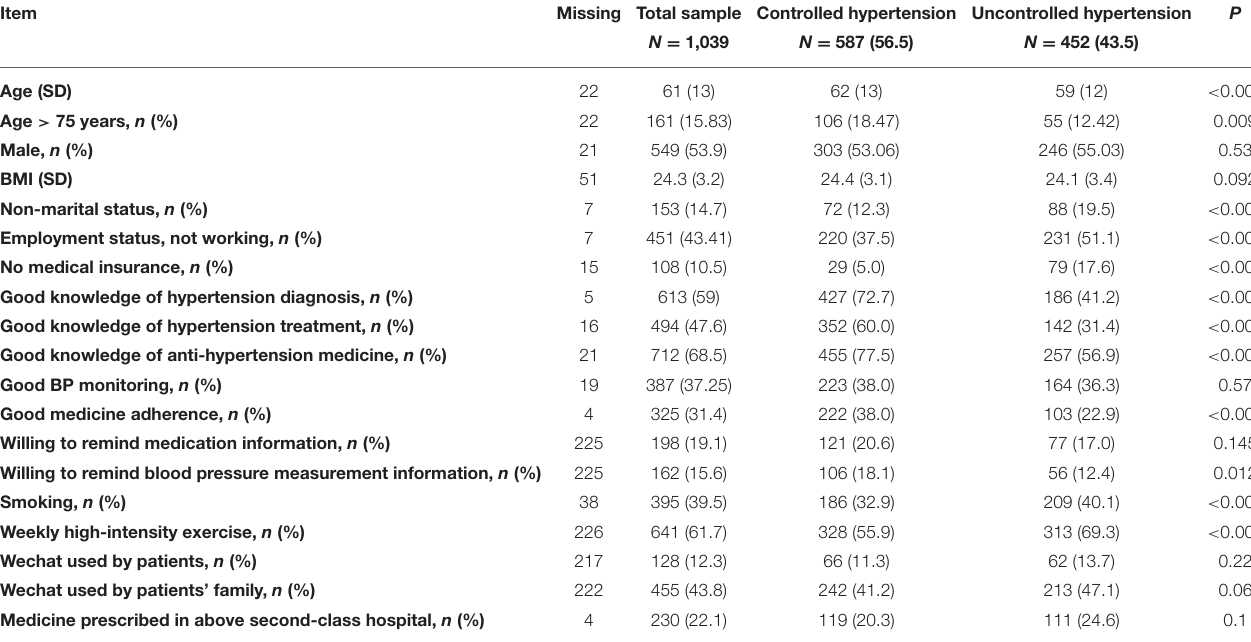
TABLE 1 | Sample characteristics of uncontrolled hypertension